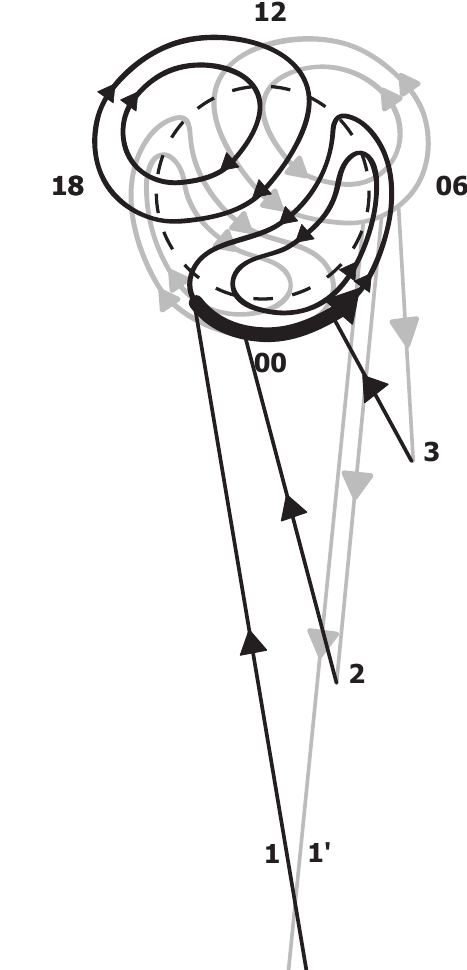
Fig. 8. Schematic of a possible mechanism by which the flow bursts are produced showing a view looking down on the northern polar ionosphere with noon to the top and dusk to the left. The open- closed field line boundary is shown as a dashed line, with the B Y - positive Dungey-cycle twin convection vortices shown as the solid arrowed curves, black for the Northern Hemisphere and grey for the simultaneous flow in the Southern Hemisphere. Tail field lines are represented by the numbered arrowed lines where 1 (1’) is a newly- reconnected field line from the Northern (Southern) Hemisphere, and 2 and 3 are the same field line at later